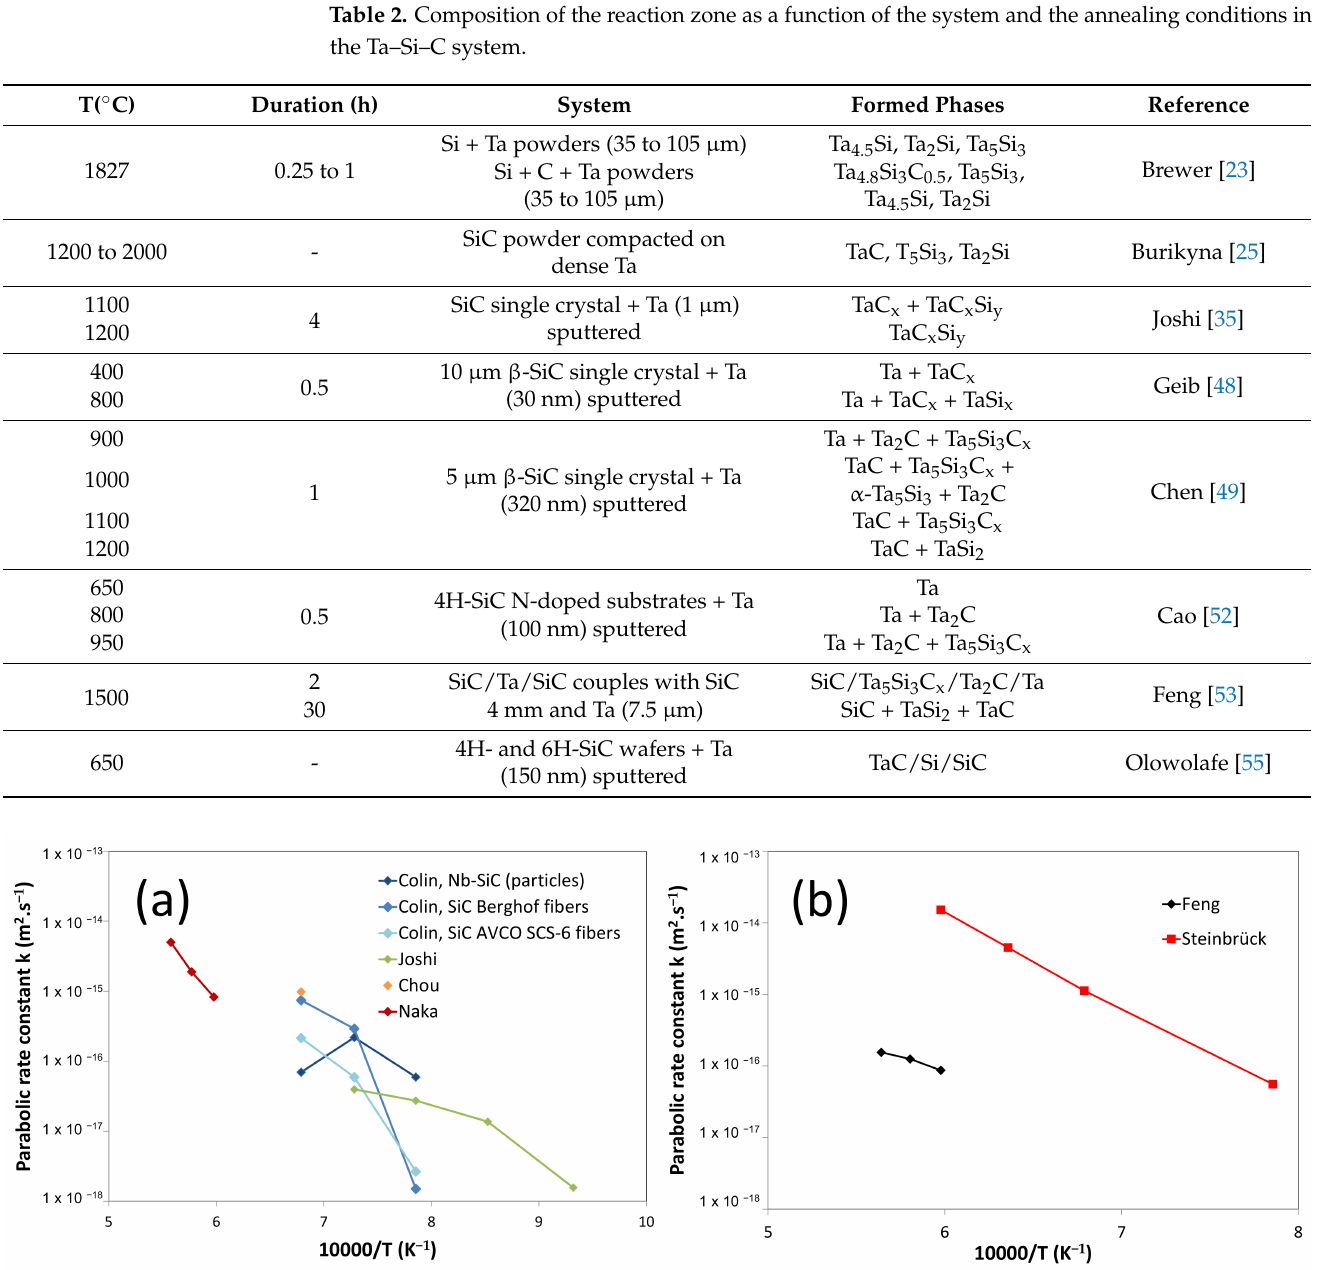
Figure 4. Parabolic rate constants ( k ) as function of temperature in ( a ) the Nb/SiC. Data adapted from [31,35,43,45] and ( b ) the Ta/SiC systems. Data adapted from